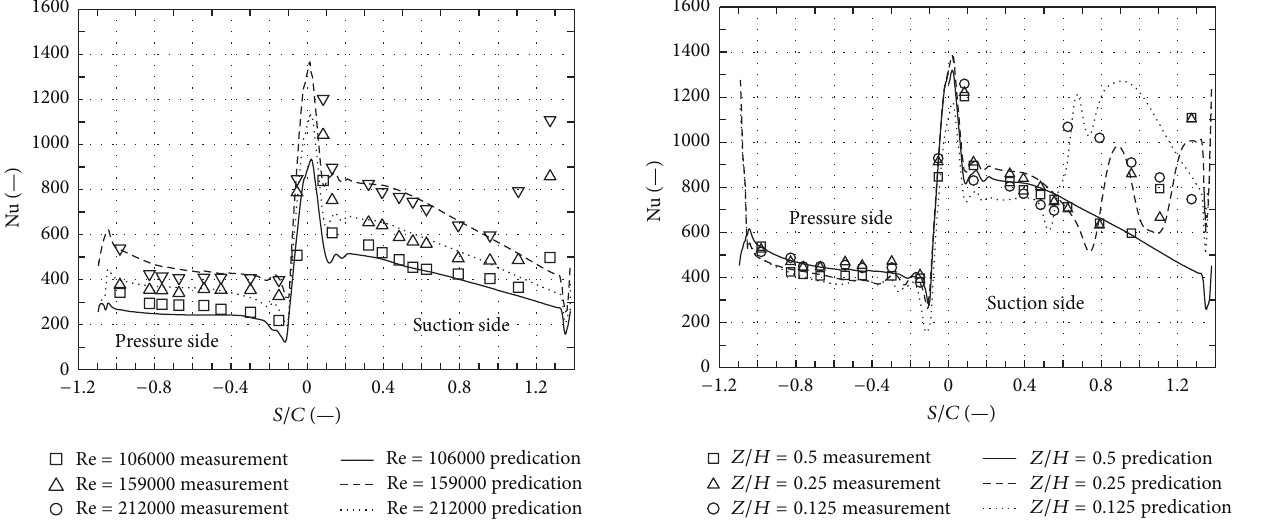
Figure 13: Effect of Reynolds number on midspan heat transfer.